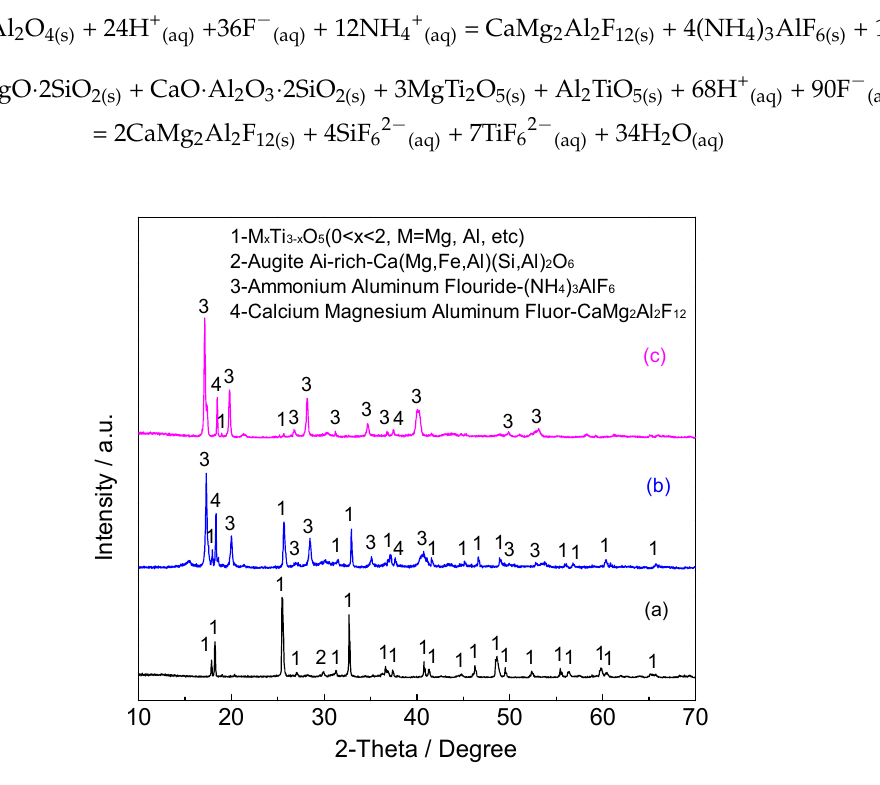
Figure 5. XRD patterns of the leaching residue at different leaching temperatures with F − concentra- tion of 10 mol/L, leaching time of 30 min, L / S ratio of 20:1, and rotating speed of 200 r/min. ( a ) Ti-bearing electric furnace slag; ( b ) Leaching temperature: 60 °C; ( c ) Leaching temperature: 90 °C.